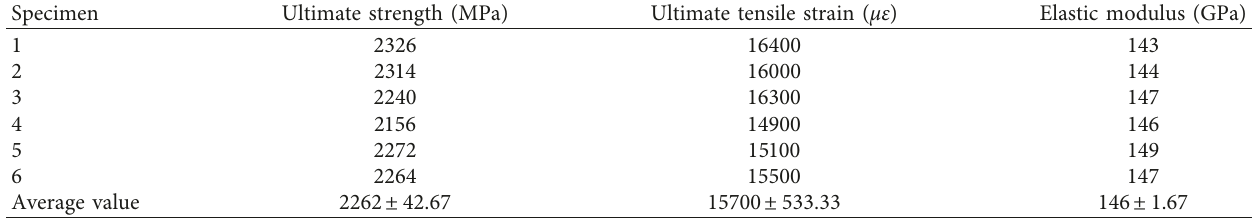
Table 6: Properties of CFRP